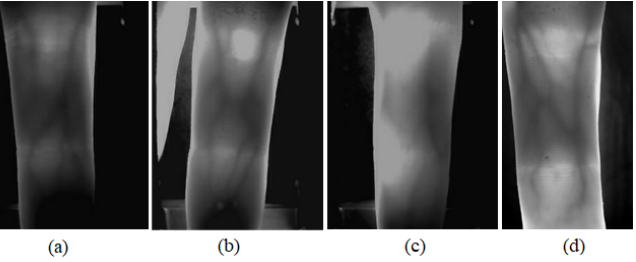
Figure 2. Typical images affecting edge extraction ( a ) Unclear borders ( b ) Wrong edge response ( c ) Unable to accurately binarize ( d ) Finger edges